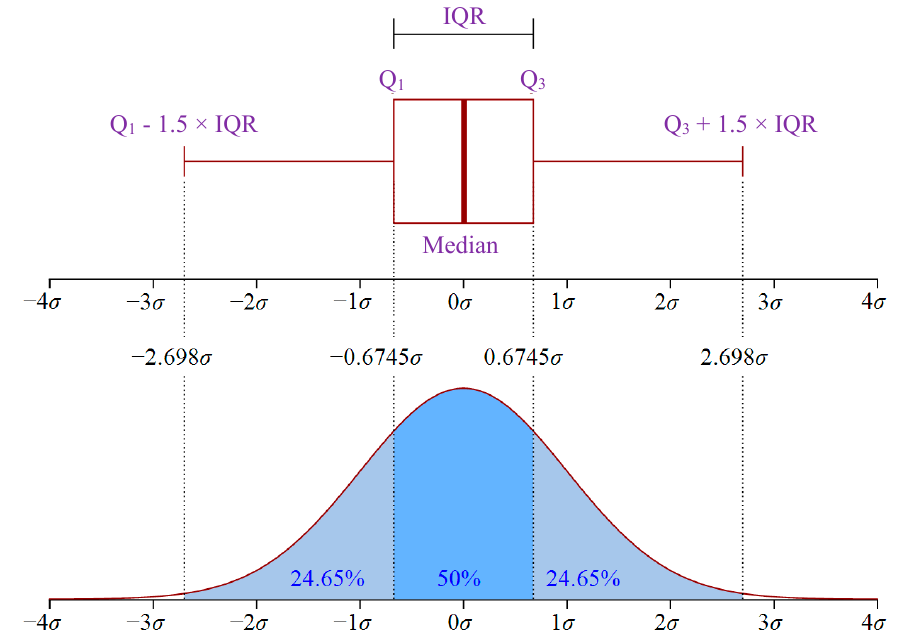
Figure 4. Boxplot with respect to a probability density function of N (0, σ 2 ).